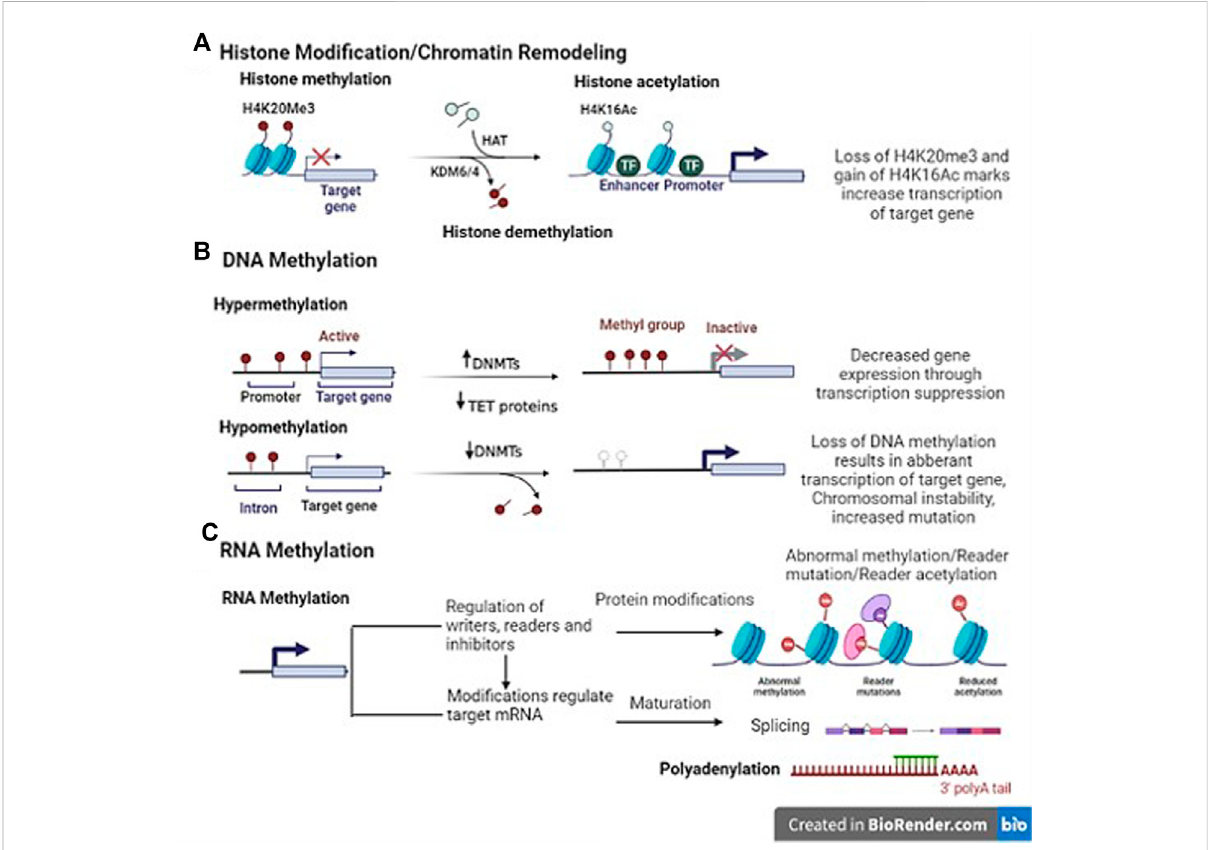
FIGURE 1 Representative image of epigenetic mechanisms (Template was created by free Biorender.com). (A) Histone modi fi cation- Histone methyltransferases (HMT) add methyl groups to histones (H4K20Me3). Histone demethylases (HDM)/Lysine demethylase (KDM6/4) remove these methyl groups. It is associated with both gene expression and silencing. Histone acetylation; The addition of an acetyl group on H3K9Ac (lysine 9 histone H3) in enhancer/promoter region by histone acetylase (HAT) enzyme. Histone deacetylase (HDAC) interact with transcriptional repressor (TR) to remove the modi fi cations. (B) DNA methylation- DNA methyltransferases (DNMTs) add methyl group in the promoter region of genes. On the contrary, DNA hypomethylation indicates overall decrease in the methylation levels as compared to normal cells, and affects the intergenic and intronic regions of the DNA, resulting in chromosomal instability and increased mutation events (C) RNA methylation- Indirect translationalrepressionbymiRNAcausesdeadenylation,inwhichthe3 ′ poly(A)tailofanmRNAisremoved,leadingtoincreasedmRNAdegradation. The miRNA – mRNA interaction can lead to several modes of direct translational